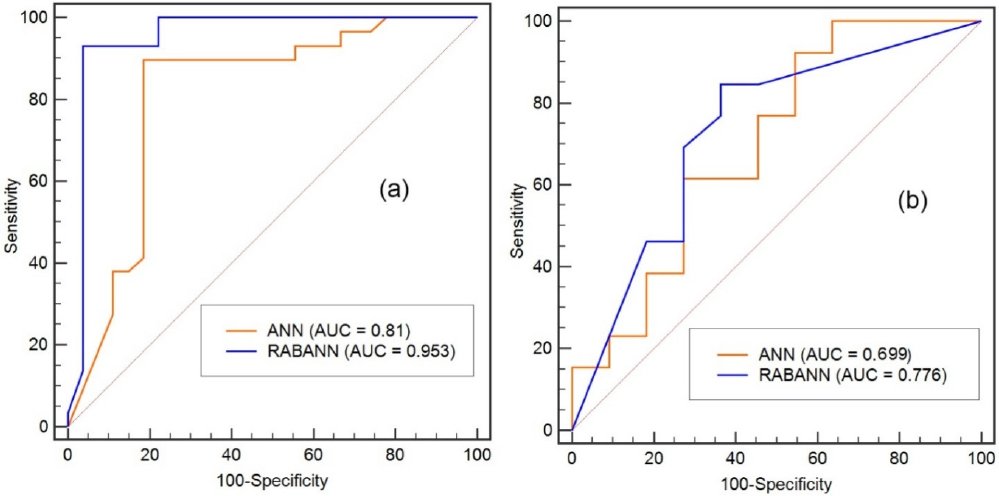
Figure 5. Receiver Operating Characteristic (ROC) curves and AUC values of the models: ( a ) training and ( b ) validation datasets.